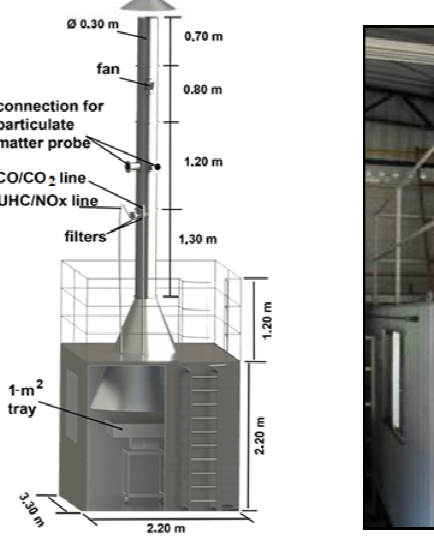
positioned on top of the balance [26]; ( c ) soil placed in the burning tray; ( d ) biomass placed in the burning